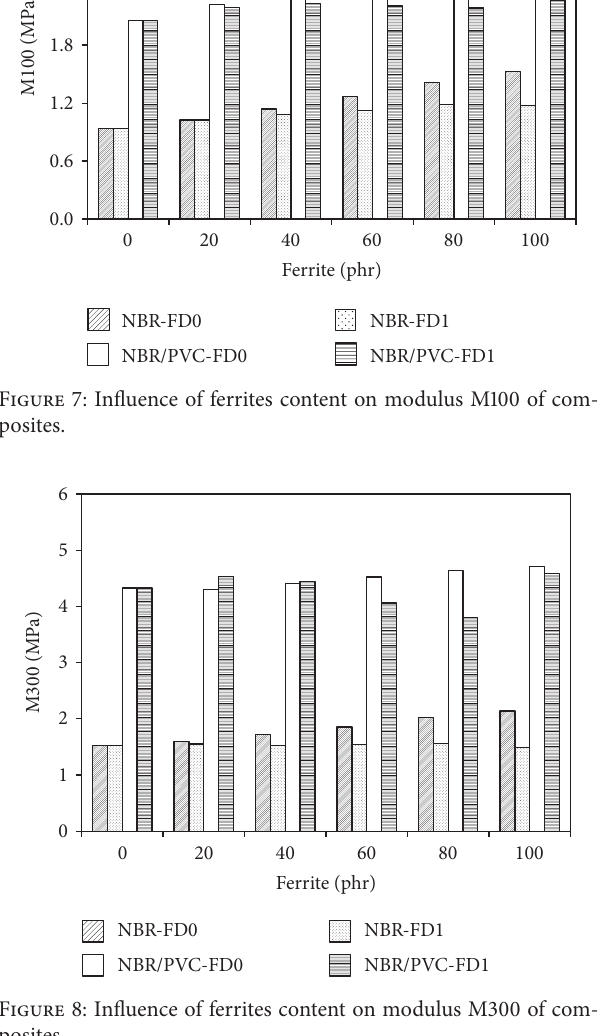
Figure 8: Influence of ferrites content on modulus M300 of com- posites.